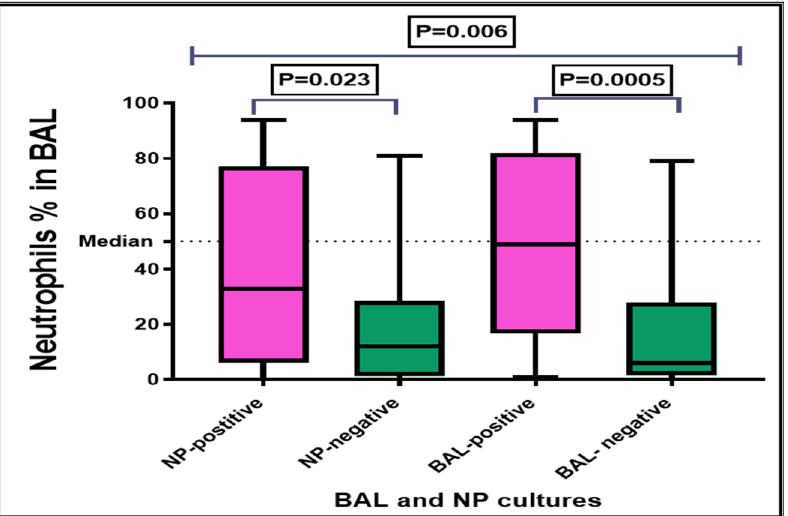
Figure 1. Median and interquartile range (IQR) of BAL neutrophil percentages in patients